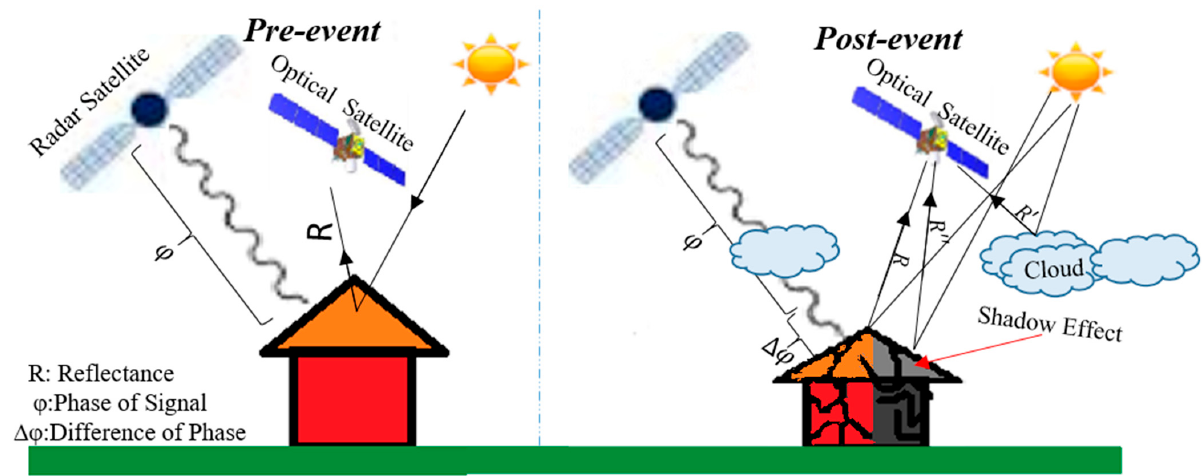
Figure 1. The ability of radar data for detecting damaged areas under cloud and shadow conditions. Airborne LiDAR systems, on the other hand, allow for the fast and extensive acquisition of precise height (altitude) data which can be used to detect some specific damage types [8]. Damage detection based on LiDAR data and a subsequent fusion with further optical data could improve the performance of damage detection, albeit with numerous limitations: (1) LiDAR data acquired by an airborne system does not cover all areas, and limitations are resulting from permission. (2) The problem of pre-event data availability persists.